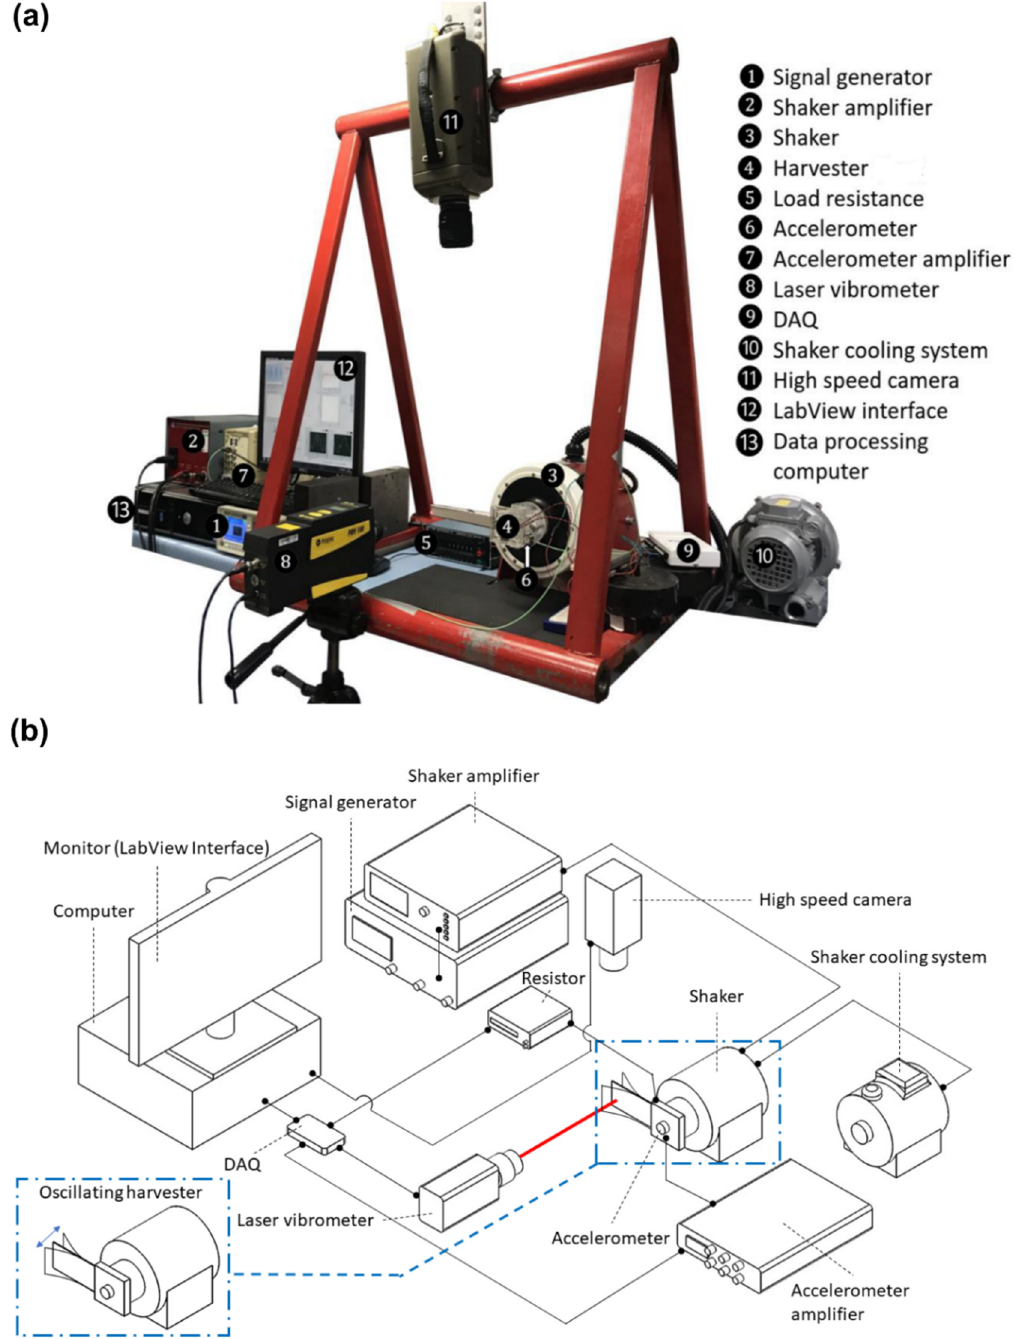
Figure 2. ( a ) Experimental setup used to test the harvesters. ( b ) Schematic of the experimental setup arrangement. It would have been possible to use the high-speed camera, instead of the vibrometer, during all tests. However, the high-speed camera is more accurate for large displacements and becomes less accurate for small displacements. It was therefore preferred to use the vibrometer for low displacement measurements, and resort to the high-speed camera only when the displacements were beyond the resolution of the vibrometer. It should be also noted that post processing of the videos was relatively time consuming compared with measurements obtained from the laser vibrometer. As our experiment involved a wide range of geometries and excitations to be measured, high-speed camera measurements were only adopted for large displacement measurements to ensure time efficiency.